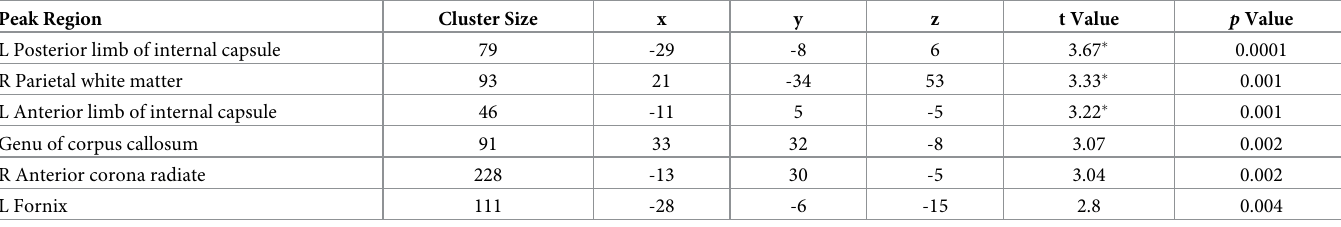
Table 4. Statistical parametric maps of the group-by-time interaction for the white matter FA (L left, R right, X, sagittal, Y, coronal, Z, axial, coordinates refers to Montreal Neurological Institute. Peak Region